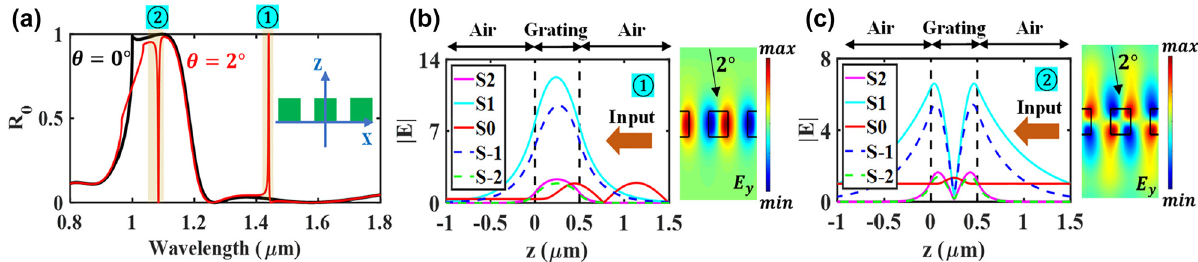
Figure 4: Resonance spectra and leaky-mode profiles under a-GMR. (a) R F = 0.5, H = 0.5 μ m, n = 2} at a crosscut of Figure 4(d) and (e) at Λ = 1 μ m. For a-GMR reflectance peak and null at ① and ② , the corresponding leaky-mode and electric-field profiles are presented in (b) and